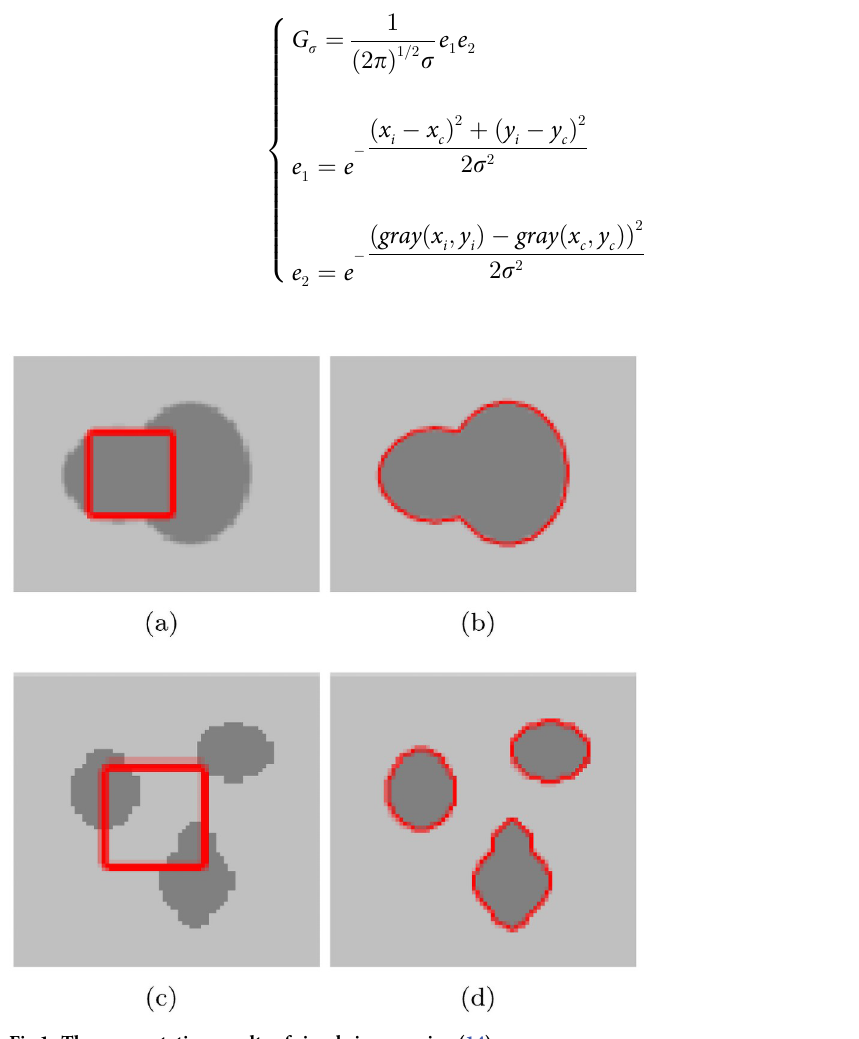
Fig 1. The segmentation results of simple image using